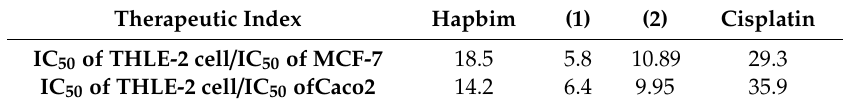
Table 3. In vitro therapeutic indices (IC 50 of normal cell / IC 50 of cancer cell line) of Hapbim and complexes ( 1 ), ( 2 ), and cisplatin in MCF-7 and Caco2 human cancer cells lines vs. THLE-2 normal